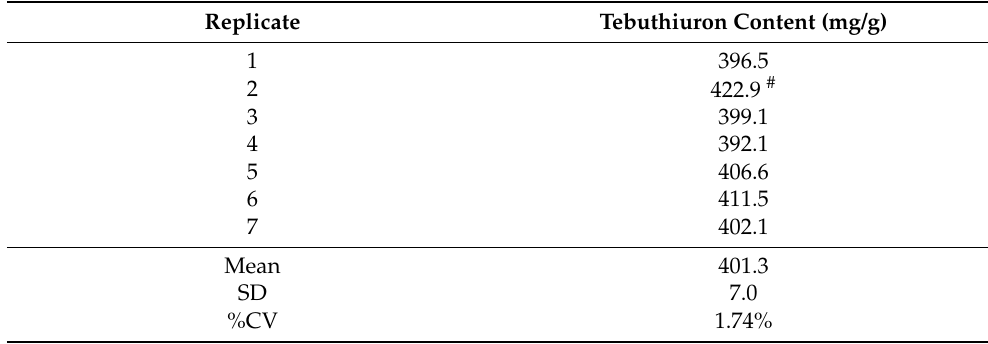
Table 3. Replicate tebuthiuron content measurements performed on replicate extracts from one powdered, homogenised Regain400 sample.